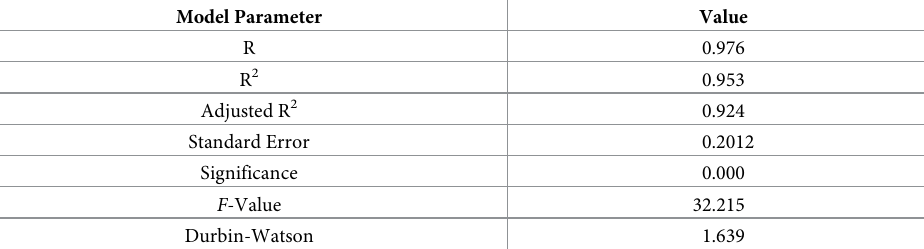
Table 7. Results of stepwise multiple linear regression for cost performance in reconstruction projects.